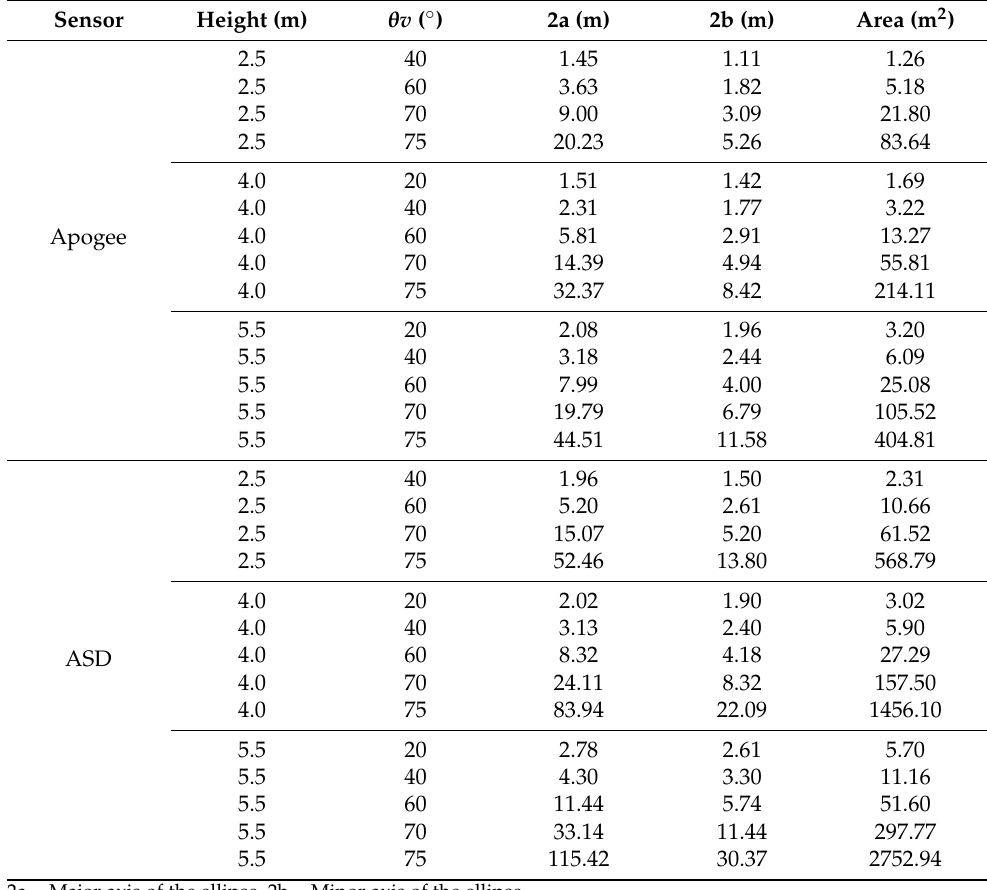
Table 3. Areas of influence of the Apogee TM sensor for an 18.4 ◦ viewing angle and ASD TM sensor for a 25 ◦ viewing angle with three different heights (parameters are described in Figure